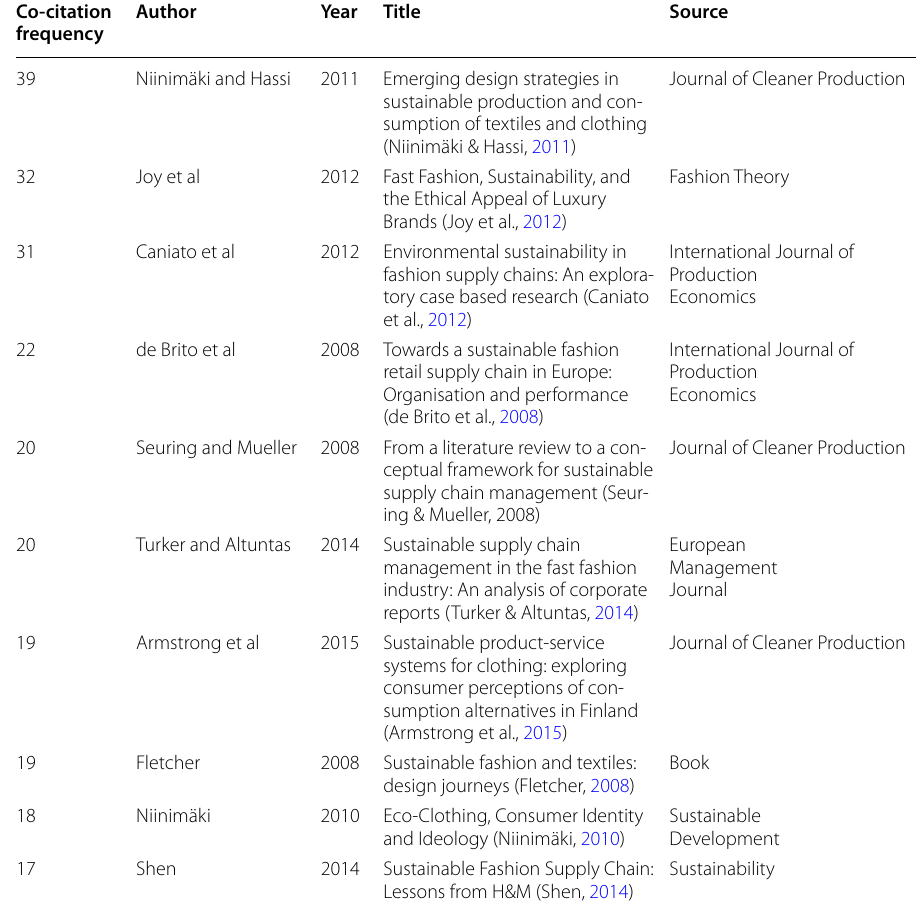
Table 2 Top 10 frequently co-cited documents for the sustainable development of the textile and apparel industry